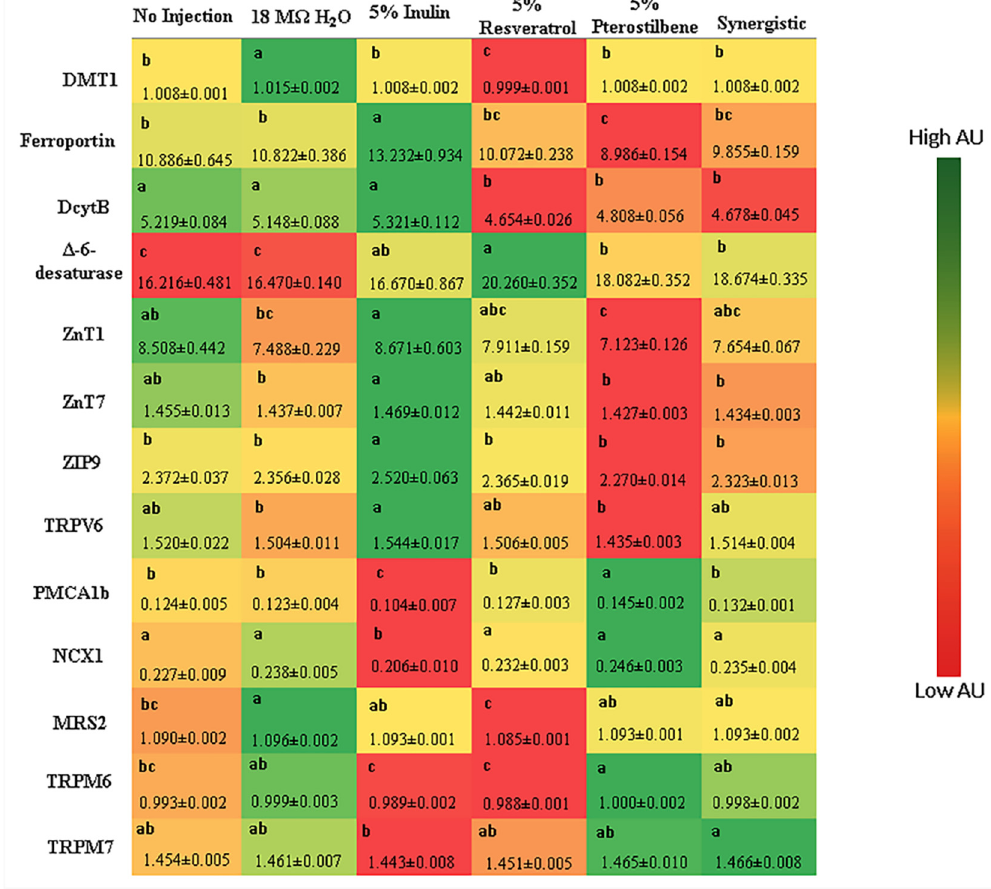
Figure 1. Effect of stilbenes administration on intestinal gene expression of proteins involved with mineral metabolism. Values are the means ± SEM ( n = 8). a–c Per gene, treatment groups not indicated by the same letter are significantly different ( p < 0.05). Iron metabolism: DMT1 = divalent metal transporter 1; DcytB = duodenal cytochrome b. Zinc metabolism: Znt and ZIP = zinc transporter proteins. Calcium metabolism: TRPV6 = transient receptor potential cation channel subfamily V member 6; PMCA1b = plasma membrane Ca 2+ ATPase isoform 1b; NCX1 = sodium-calcium exchanger 1. Magnesium metabolism: MRS2 = mitochondrial magnesium channel type 2; TRPM6 and TRPM7 = transient receptor potential